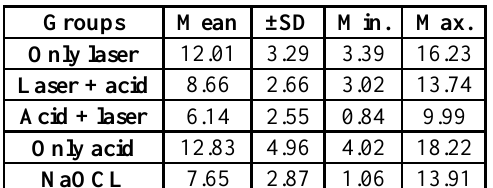
Table 1: Means and Standard deviations of